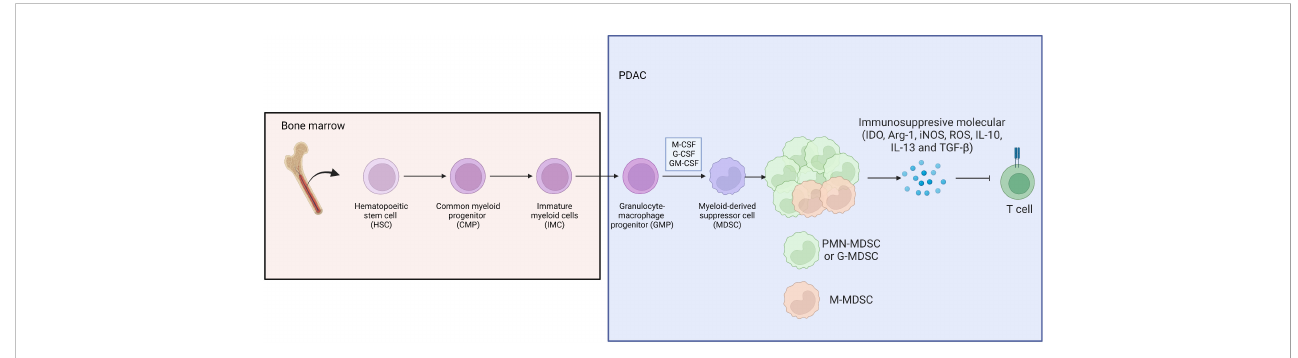
FIGURE 5 Bone marrow derived HSC differentiate to CMP, IMP and GMP, then develop into MDSC under stimulation of M-CSF, G-CSF and GM-CSF in PDAC, where G-MDSC occupied the majority of MDSC